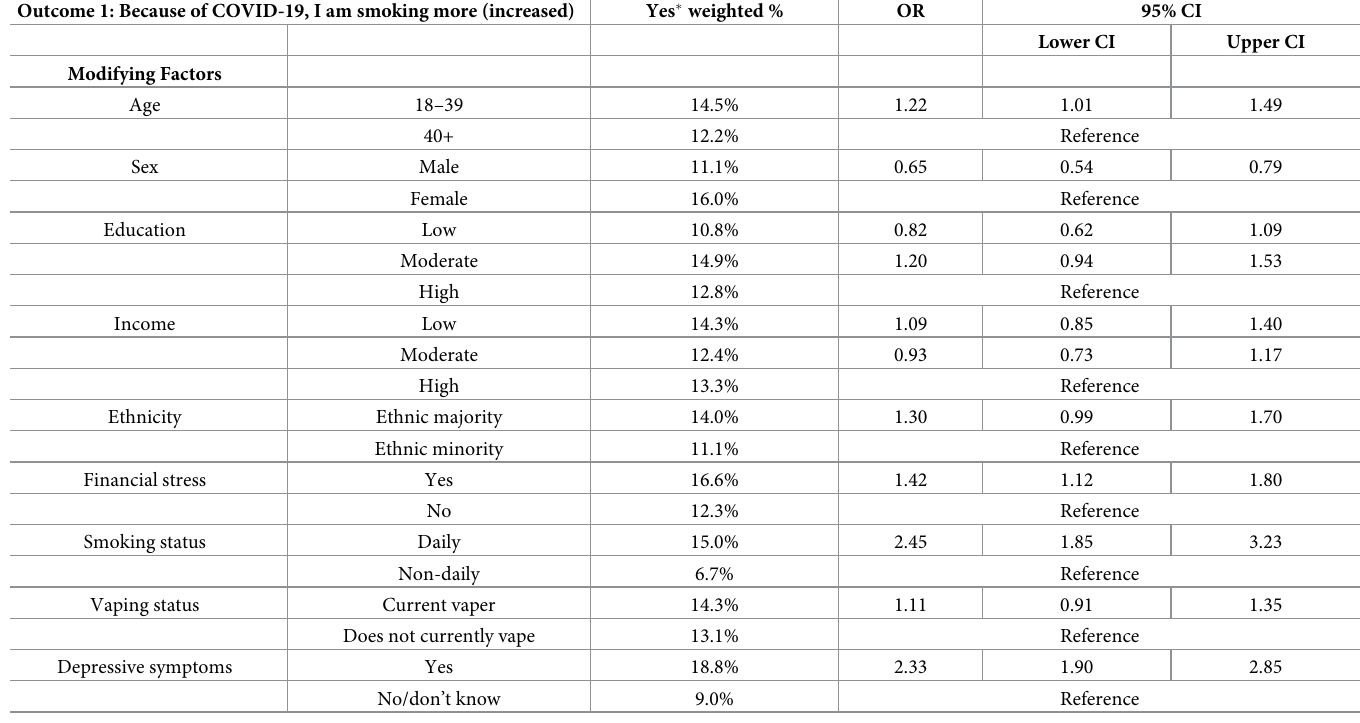
found that nearly half the sample reported that they thought about quitting because of COVID-19, the majority did not try to stop. This was also reflected in the US study of dual users who reported increased motivation to quit smoking if they perceived smoking increased their risk of harm from COVID-19, but most smokers did not change their smoking patterns [31]. Both of these studies have shown that smokers were concerned about COVID-19 and increased risk, but it appears that the pandemic did not carry enough weight to provoke actual quit attempts. Additionally, while we found that only a small proportion of the sample reduced smoking or made a quit attempt because of COVID-19, individual’s beliefs were strongly Table 6. Personal modifying factors related to increased smoking because of